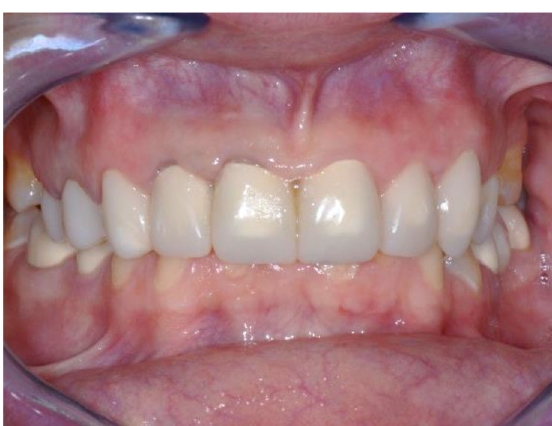
Figure 11. PMMA crowns cemented in the